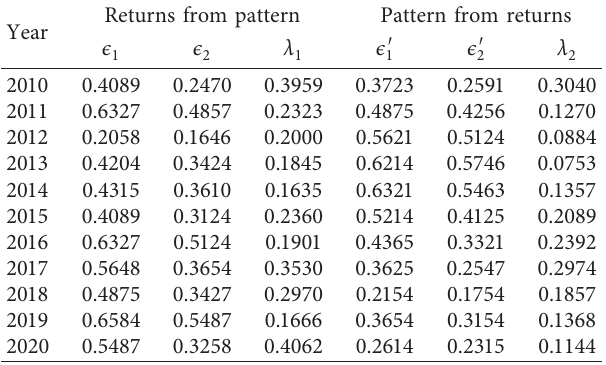
Table 7: Prediction error reduction index of Index NIFTY 50 for the period 2010–2020.